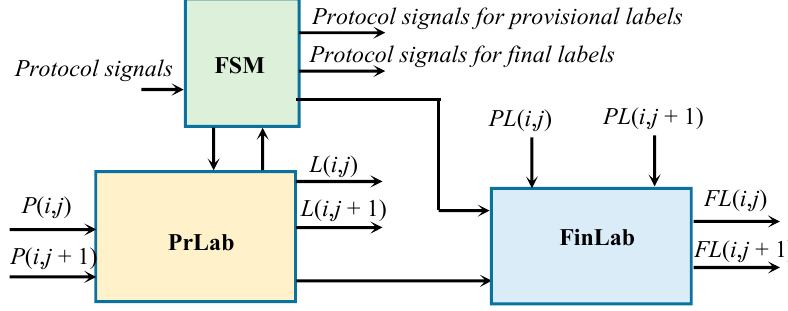
Figure 8. Top-level architecture of the proposed hardware design.